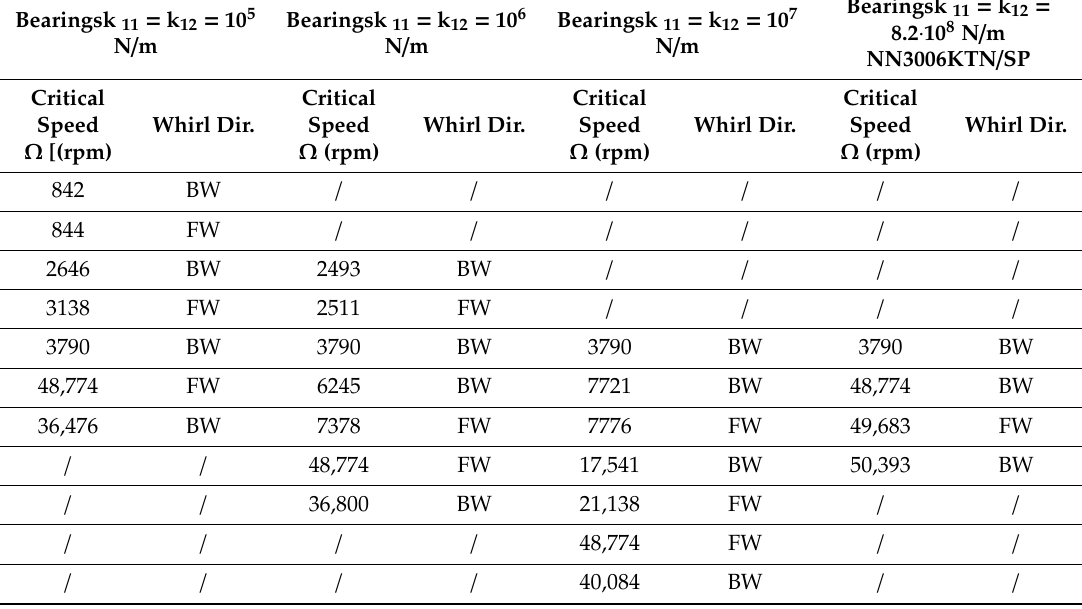
Table A2. Critical speeds of IPM rotor with the